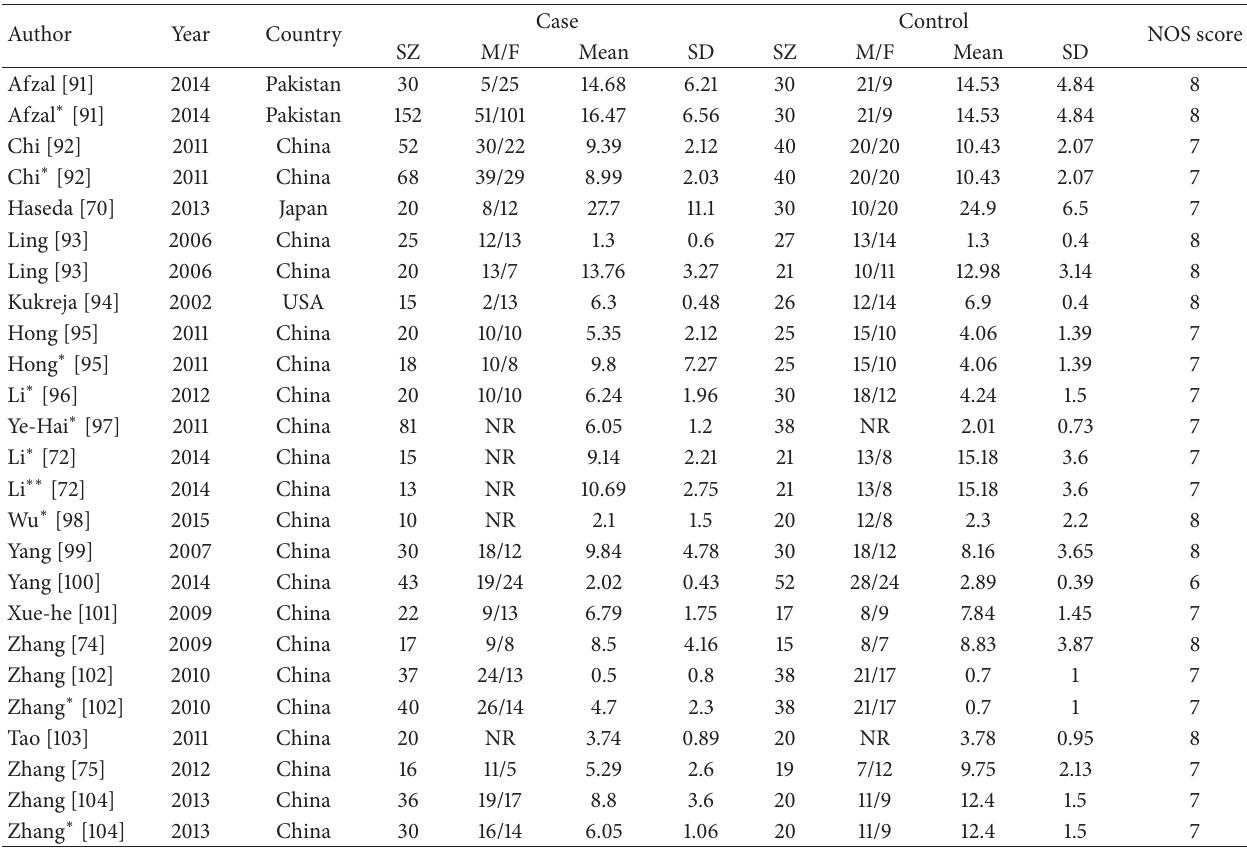
Table 6: Characteristics of studies about the percentage of CD4 + CD25 + Tregs (%) in the CD4 + lymphocyte included in this meta-analysis. Author